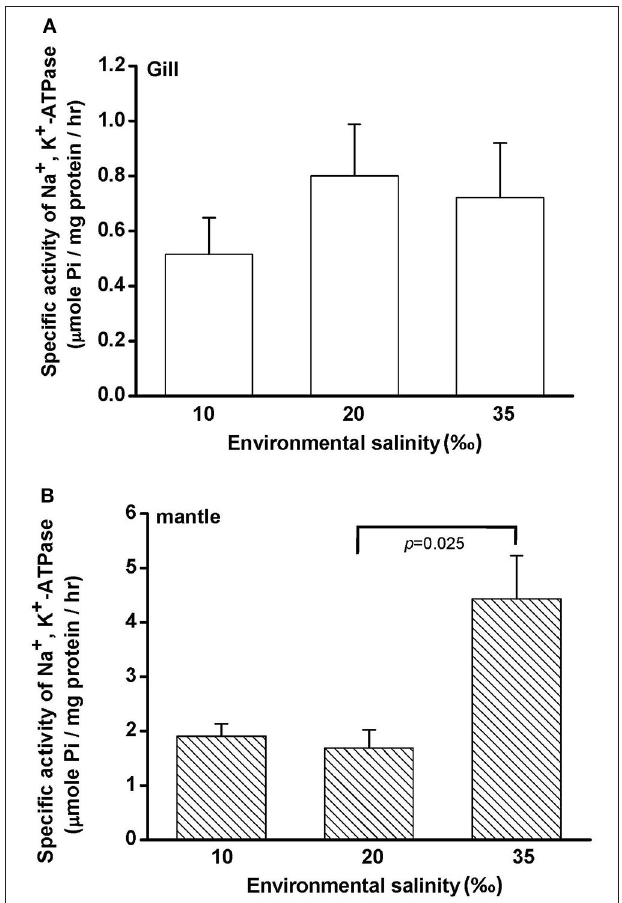
FIGURE 2 | Salinity effects on Na + , K + -ATPase activities in the gill (A) and mantle (B) of the hard clam. Statistical analysis was performed with one-way ANOVA followed by Dunnett’s test. The 20 ‰ SW group was used as a control. p < 0.05 was considered statistically significant. Values are means ± SEM. ( N = 5).